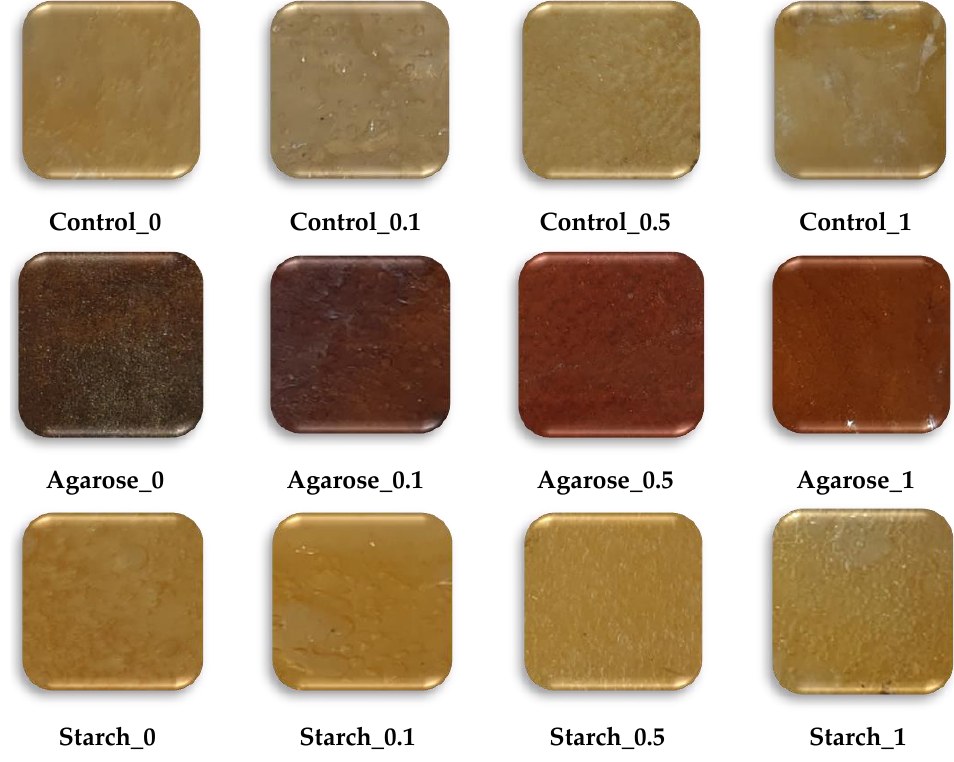
Figure 14. Synthesized blends (CanoScan